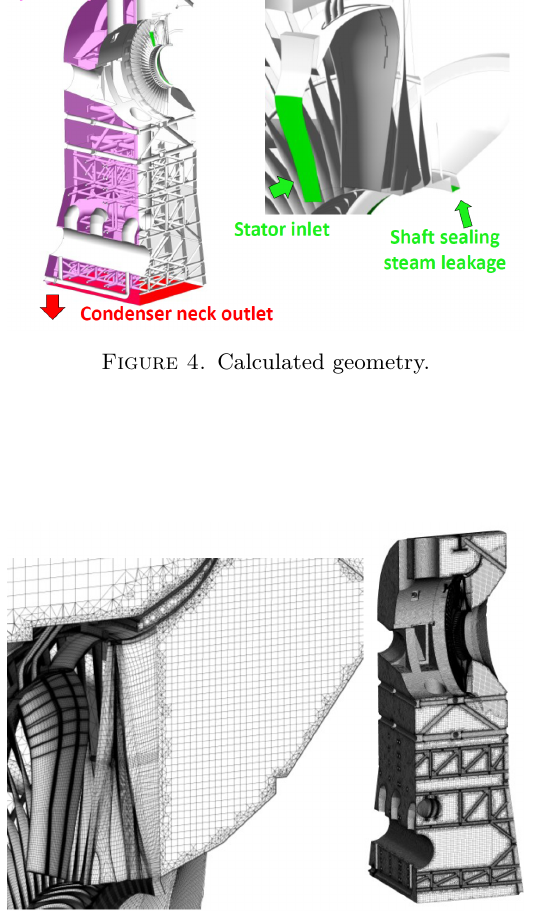
Figure 5. Computational